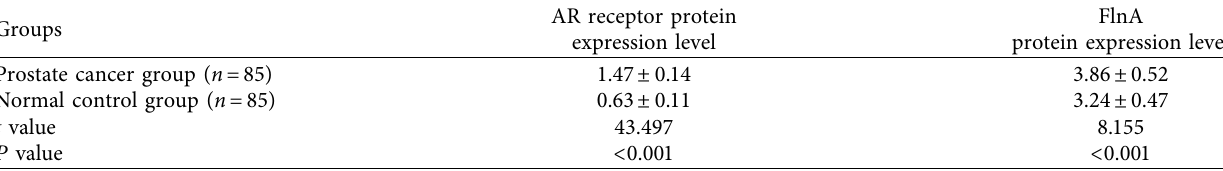
Table 4: Expression of AR/FlnA complex between the subjects of two groups (/ β -actin antibody).